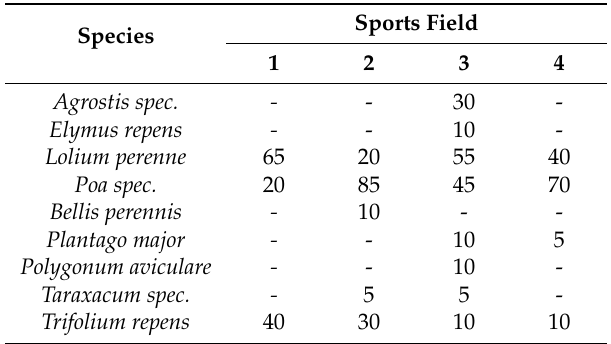
Table 3. Vegetation analysis of 4 sports fields conducted in July 2015. Degree of coverage is given in %. Sports Field Species 1 2 3 4 Agrostis spec. - - 30 - Elymus repens - - 10 - Lolium perenne 65 20 55 40 Poa spec. 20 85 45 70 Bellis perennis - 10 - - Plantago major - - 10 5 Polygonum aviculare - - 10 - Taraxacum spec. - 5 5 - Trifolium repens 40 30 10